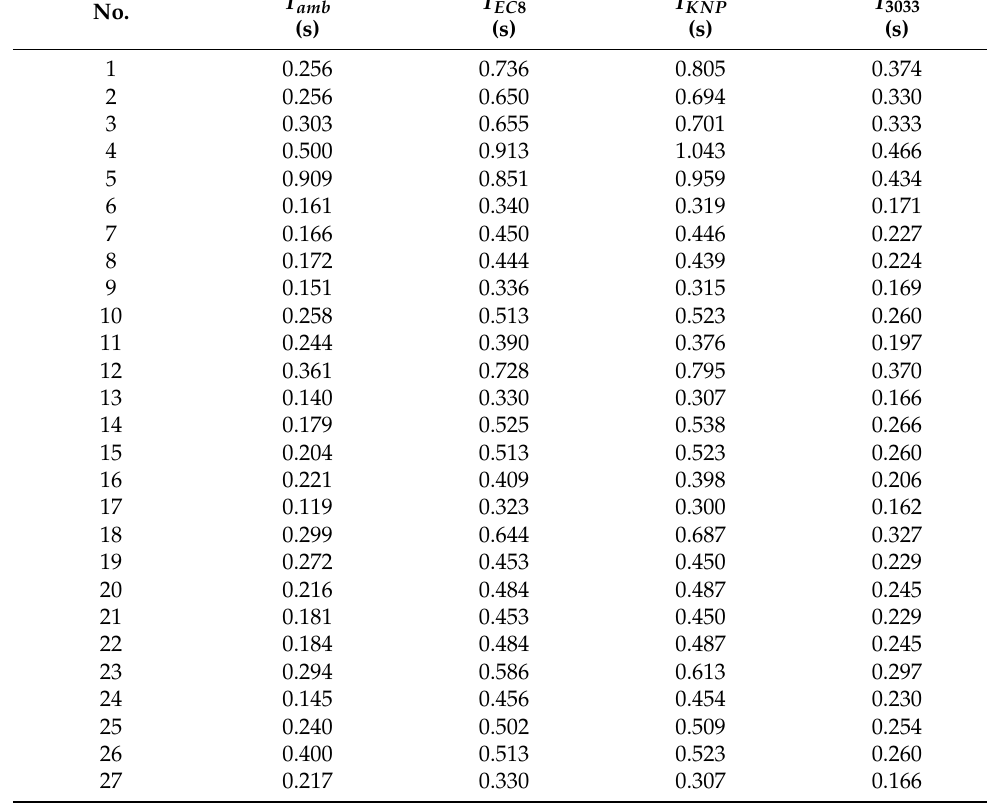
Table A1. Experimental and theoretical values of the effective 1st period for the 27 RC buildings. No.